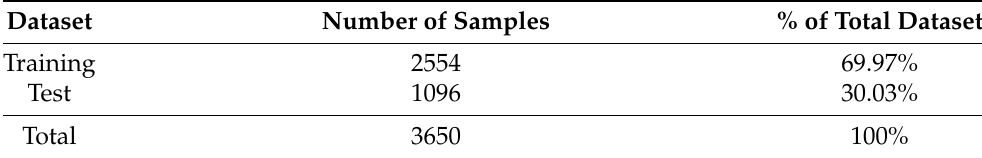
Table 1. Dimensions of the datasets used for training and testing the Multilayer Perceptron (MLP) model. Dataset